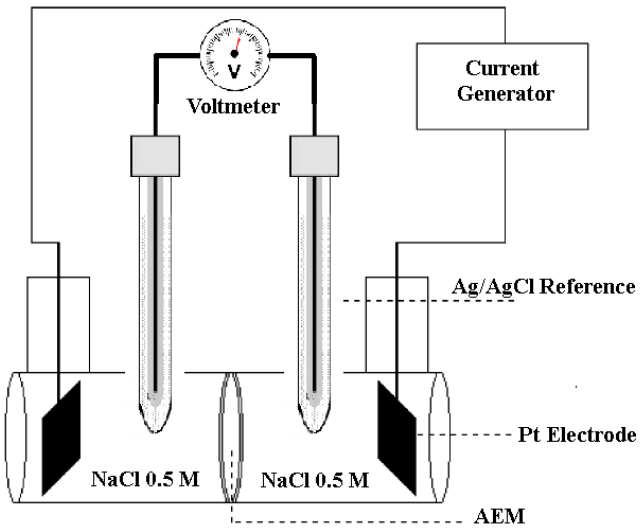
Figure 2. Schematic representation of experimental conductivity cell.